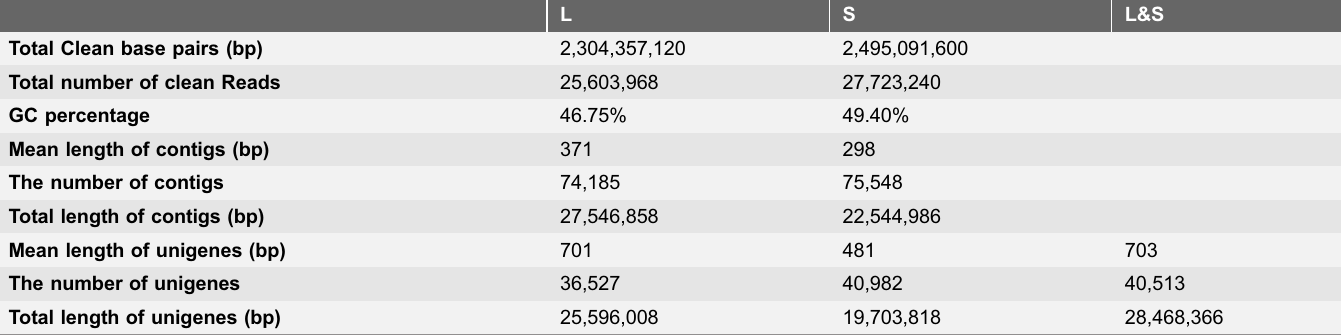
Table 1. Summary of sequence assembling results after Illumina sequencing of cDNA libraries from ‘Sijimi’ and ‘Lidongben’ of